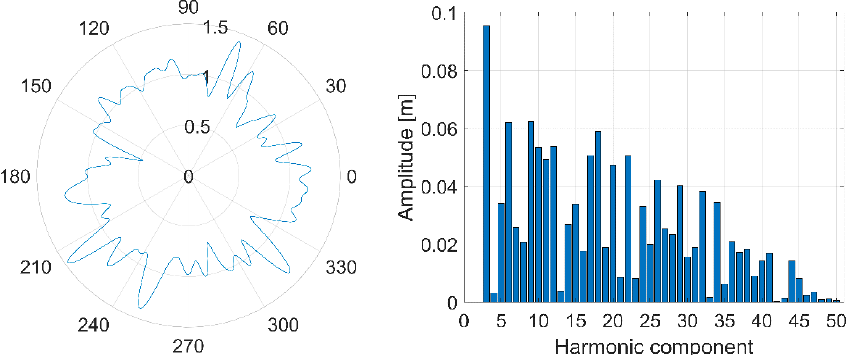
Figure 11. Generated solid profile including components 3–50 at the top and the component am- plitude deviation at the bottom.